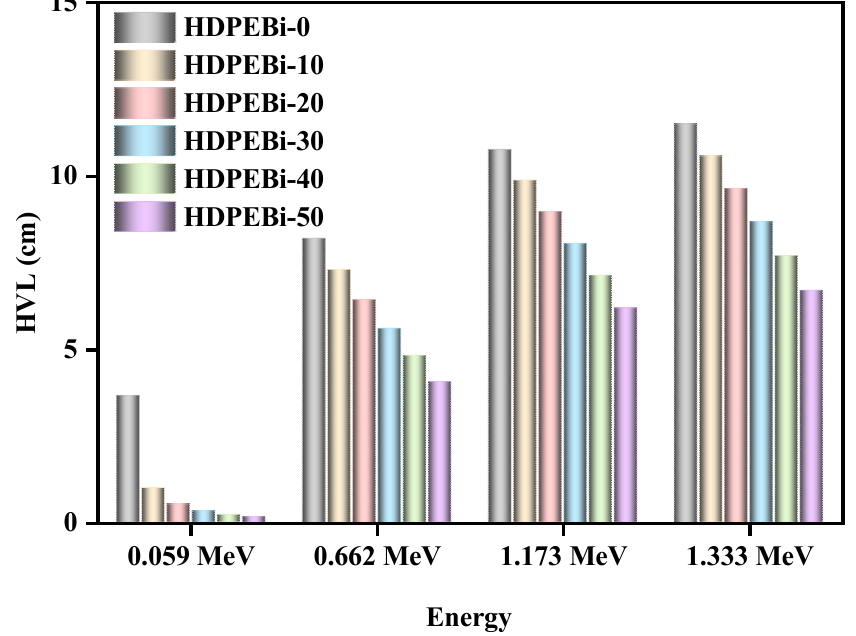
Figure 7. Half-value layer values as functions of photon energy (experimental results). To validate the efficacies of pure HDPE (without Bi 2 O 3 ) and of the HDPE (with 10– 50% Bi 2 O 3 ) systems, the mean free path (MFP) values were examined herein for identify- ing the radiation shielding ability and the gained MFP fallouts for the pure and contami-